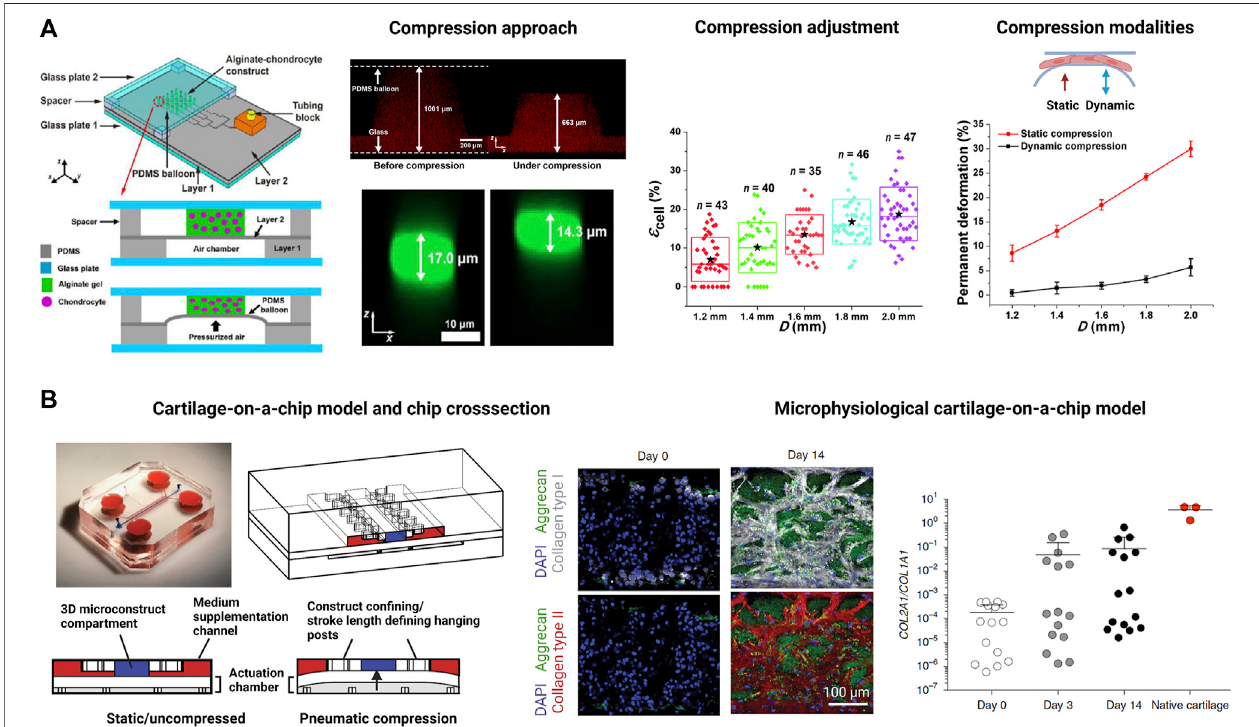
FIGURE3| Examplesforbiomechanically actuatedjoint-on-a-chipsystems. (A) Amicro fl uidicpneumatic-actuationdevicetransmittingmultiplemechanicalstress conditions on chondrocyte-laden alginate hydrogel to study deriving mechanisms of bone growth. Via a pneumatic channel network, pressurized air de fl ates a silicone (PDMS) balloon to compress chondrocytes. For instance, hydrogel compression of 34% in the z direction (red fl uorescence) leads to a compression of individual chondrocytes within the hydrogel by 16% (green fl uorescent cells). Increase of the diameter of the silicone balloon gradually increases cell loading by up to 30% under constant and cyclic loading conditions (see graphs on the right). Reproduced with permissions from (Lee et al., 2018). (B) Development of a cartilage-on-a-chip (left panel) where a 3D cartilage construct (blue compartment) enclosed by two medium supplementation channels (red highlights) is actuated by pneumatic compression of a de fl ectable membrane (white membrane). Physiological compression of 10% results in a native tissue-like matrix biosynthesis (center panel) comprising high levels of aggrecan (green fl uorescence), collagen type I (white fl uorescence), and collagen type II (red fl uorescence). Analysis of the Collagen type